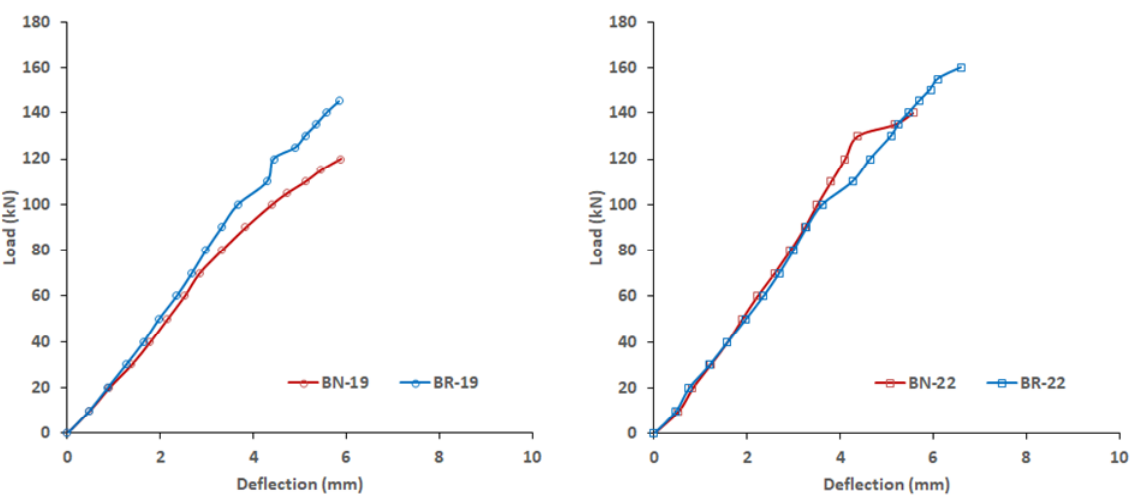
Figure 5. Load-deflection behaviour.